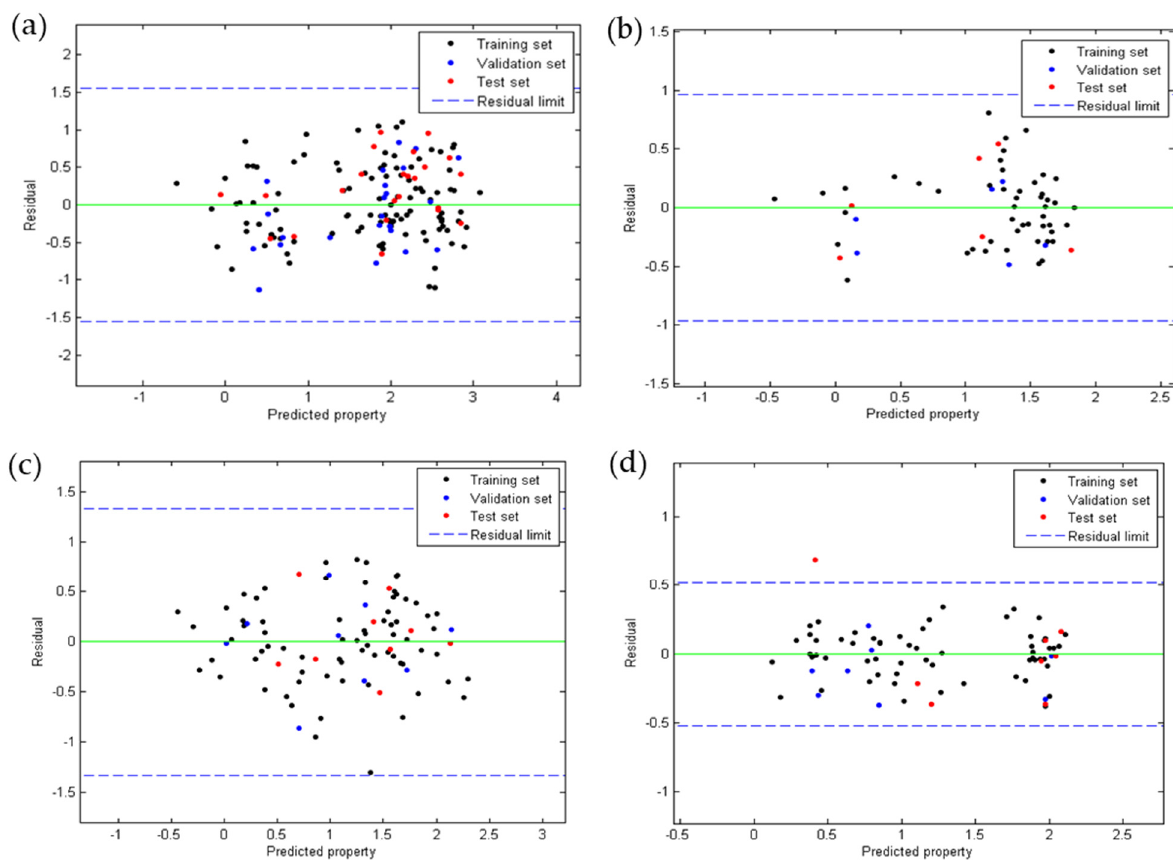
Figure 2. Dispersion of residues according to QSAR Equations (1) ( a ), (2) ( b ), (3) ( c ), and (4) ( d ). QSAR models established according to Equations (1)–(4) were used to predict anti- chagas (IC 50 in trypomastigotes), anti- L. amazonensis (cutaneous and mucocutaneous leish- maniasis), and anti- L. infantum (visceral leishmaniasis) activity, as well as toxicity, of